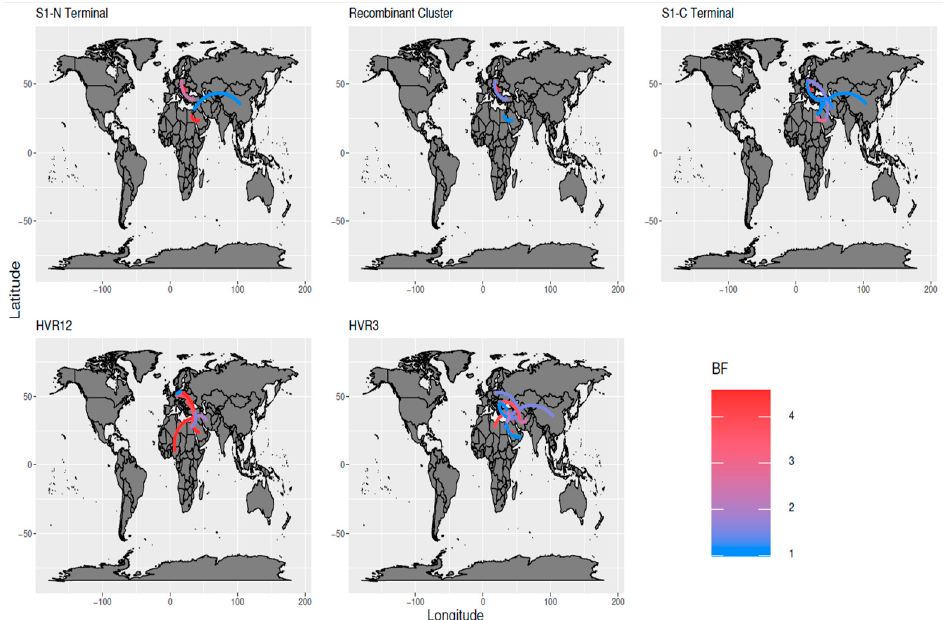
Figure 5. Well supported migration paths among countries are depicted as edges whose colour is proportional to the BF of the migration rate. The location of each country has been matched with its centroid.